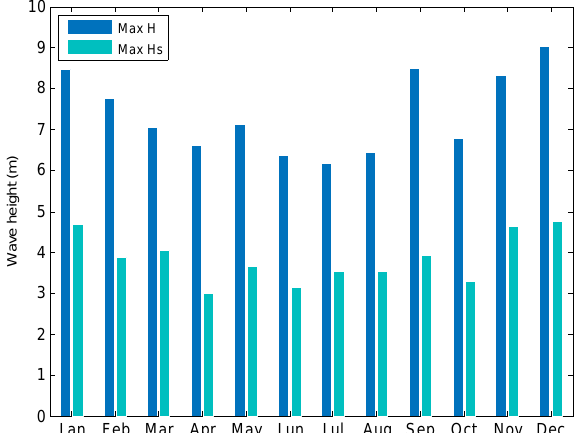
Figure 4. Annual variation of the monthly maximum wave height and the monthly maximum significant wave height at the Lysekil test site in the years